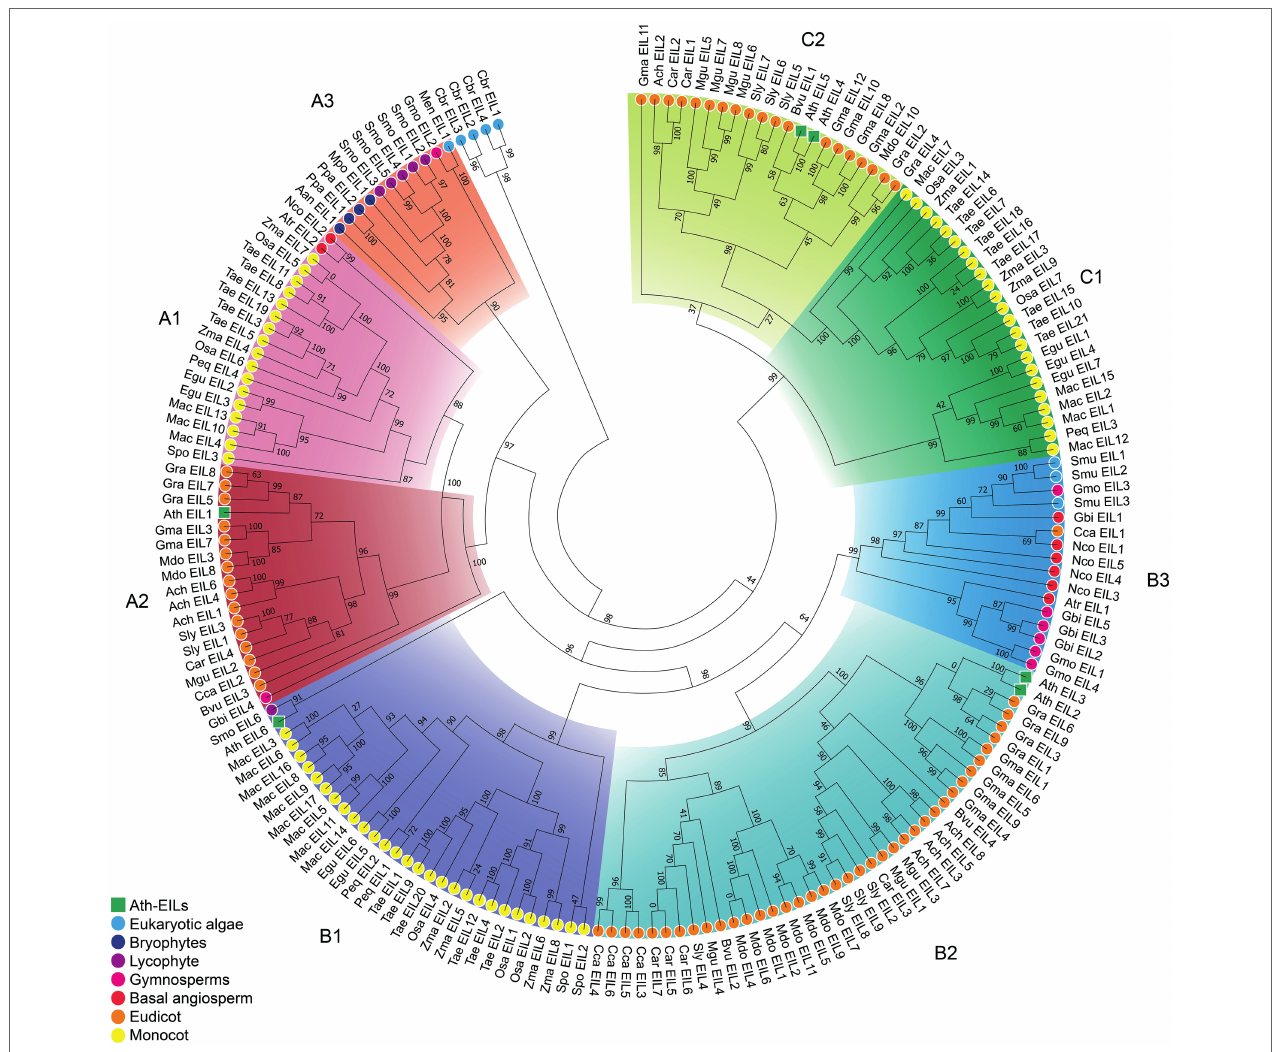
FIGURE 2 | Phylogenetic analysis of 182 EIL proteins from 28 species. The phylogenetic tree of all sequences was constructed using PhyML by the Maximum Likelihood (ML) method. The root of the tree is the sequence of Chara braunii